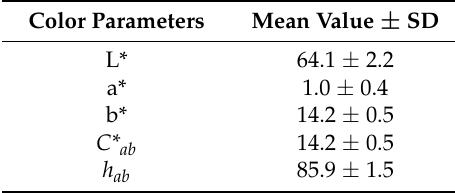
Table 4. Colorimetric data of A. mollis aerial parts using an independent color-space